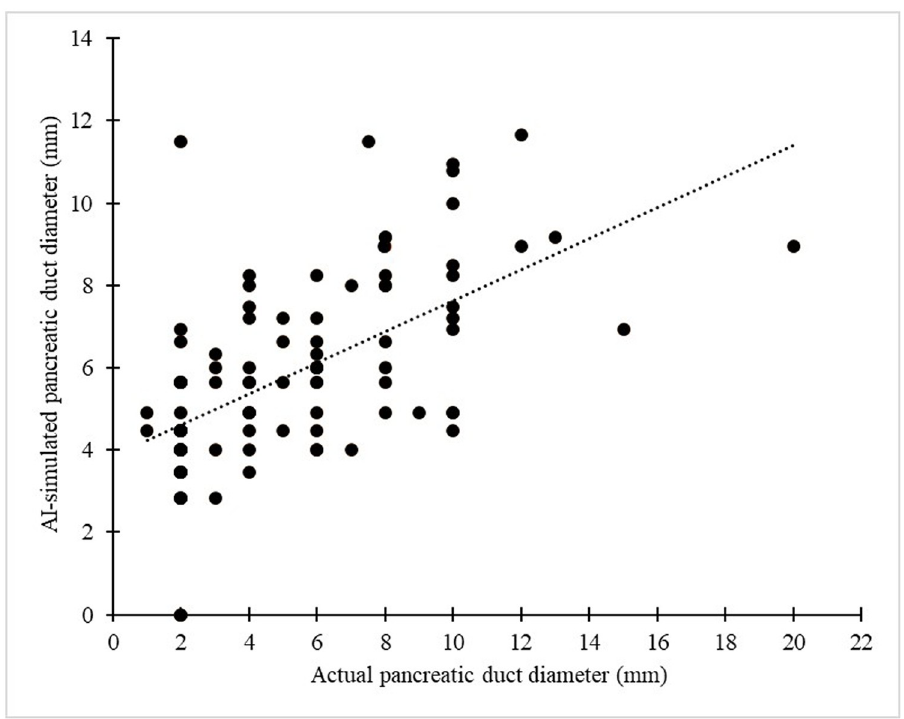
Fig 8. Correlation between AI-simulated diameter and actual diameter of the pancreatic